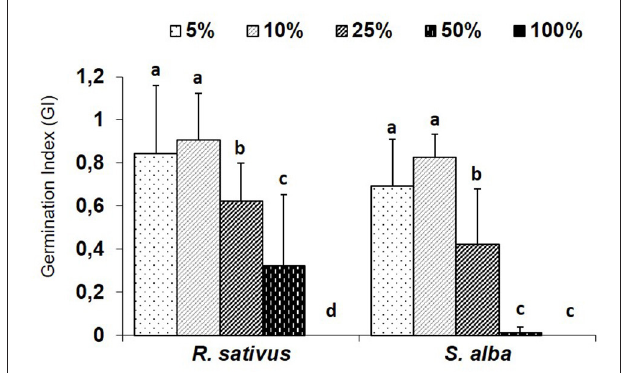
FIGURE 3 | Survival and infectivity of Phytophthora nicotianae after laboratory experiments. Brassica carinata pellets at 3 tons ha − 1 (BF3); B. carinata pellets at 6 tons ha − 1 (BF6); control non-amended and inoculated (CPhy + ). Treatment followed by AS was prepared with autoclaved soil. Survival was determined by detecting P. nicotianae with carnation petals as baits and was expressed as % of positive baits ( n = 10). Infectivity was determined by bioassays with pepper plants and expressed as % of diseased plants ( n = 5). Values are means ± SD ( n = 4). For survival, different letters in bars indicate significant differences [Chi 2 = 66.23; P < 0.001, followed by Tukey’s multiple range test ( P < 0.05)]. For infectivity, different letters in bars indicate marginally significant differences (Chi 2 = 10.17; P = 0.037), followed by Tukey’s multiple range test ( P < 0.056).